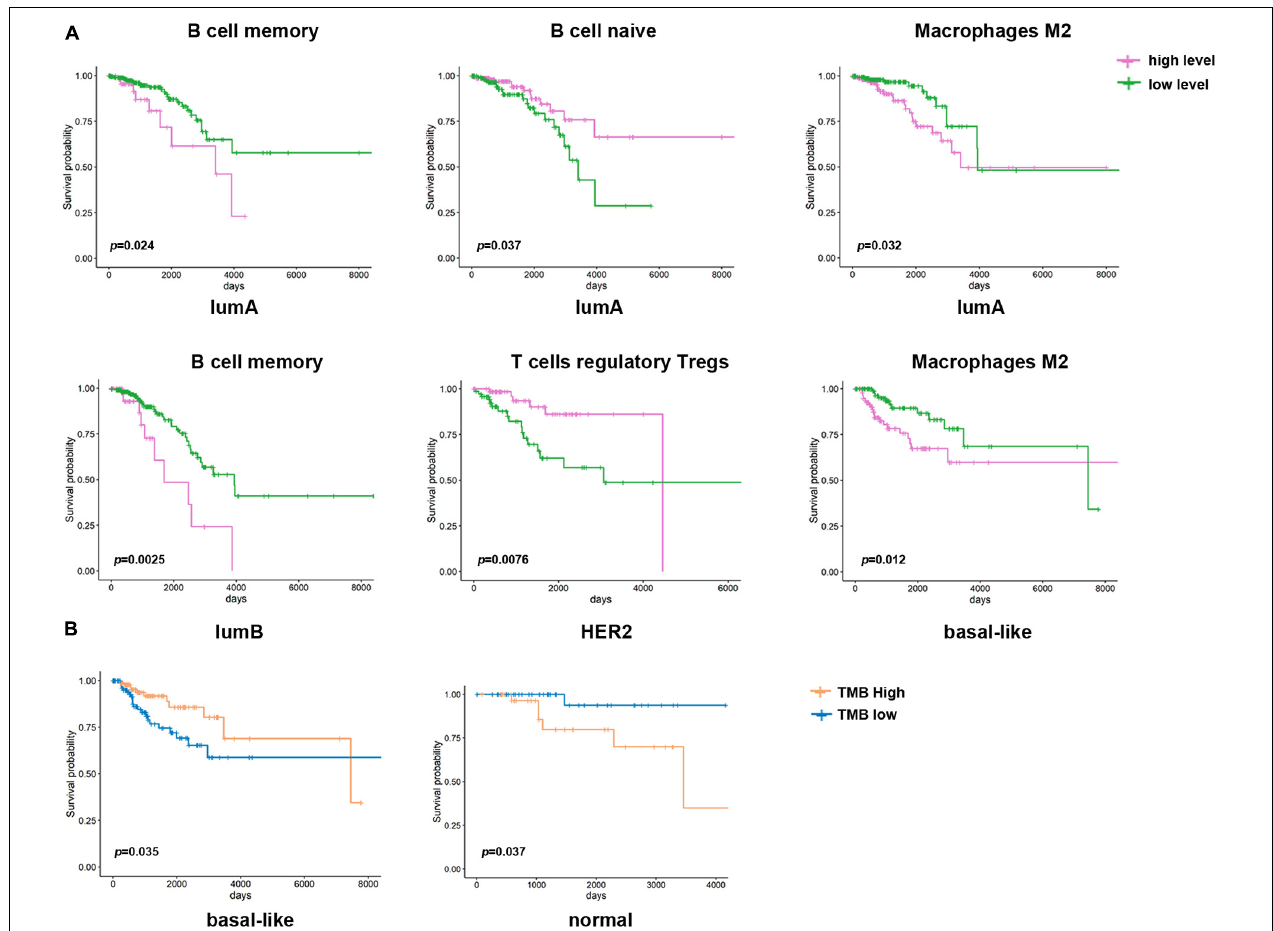
FIGURE 6 | Kaplan–Meier survival curve of immune cells and TMB in different breast cancer subtypes. (A) Kaplan–Meier survival curve of the immune cell infiltration level in different breast cancer subtypes ( p < 0.05). Purple represents a high level of infiltration, and green represents a low level of infiltration. (B) Kaplan–Meier survival curve of TMB in different breast cancer subtypes. Blue represents the high TMB group, and orange represents the low TMB